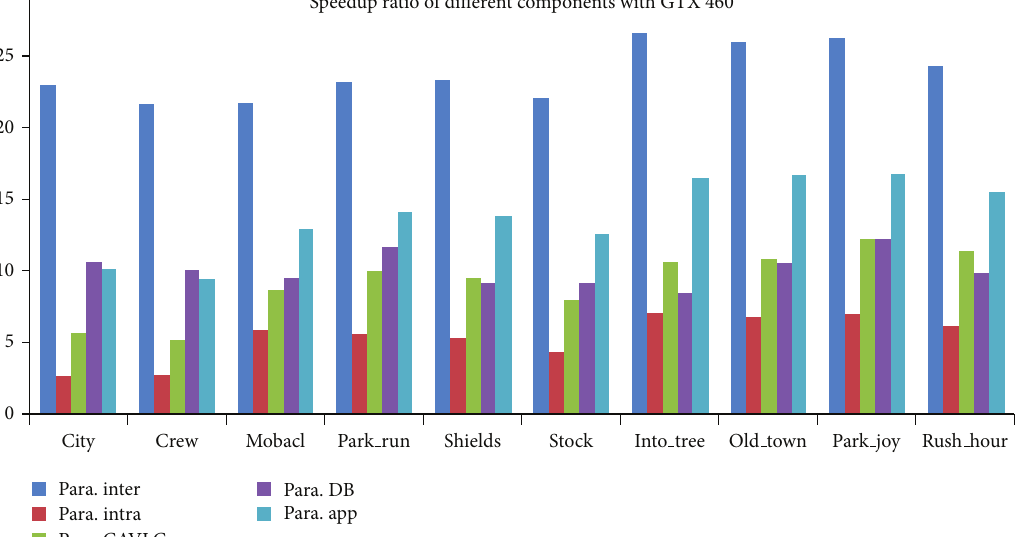
Figure 17: Speedup ratio of the proposed parallel H.264 encoder on